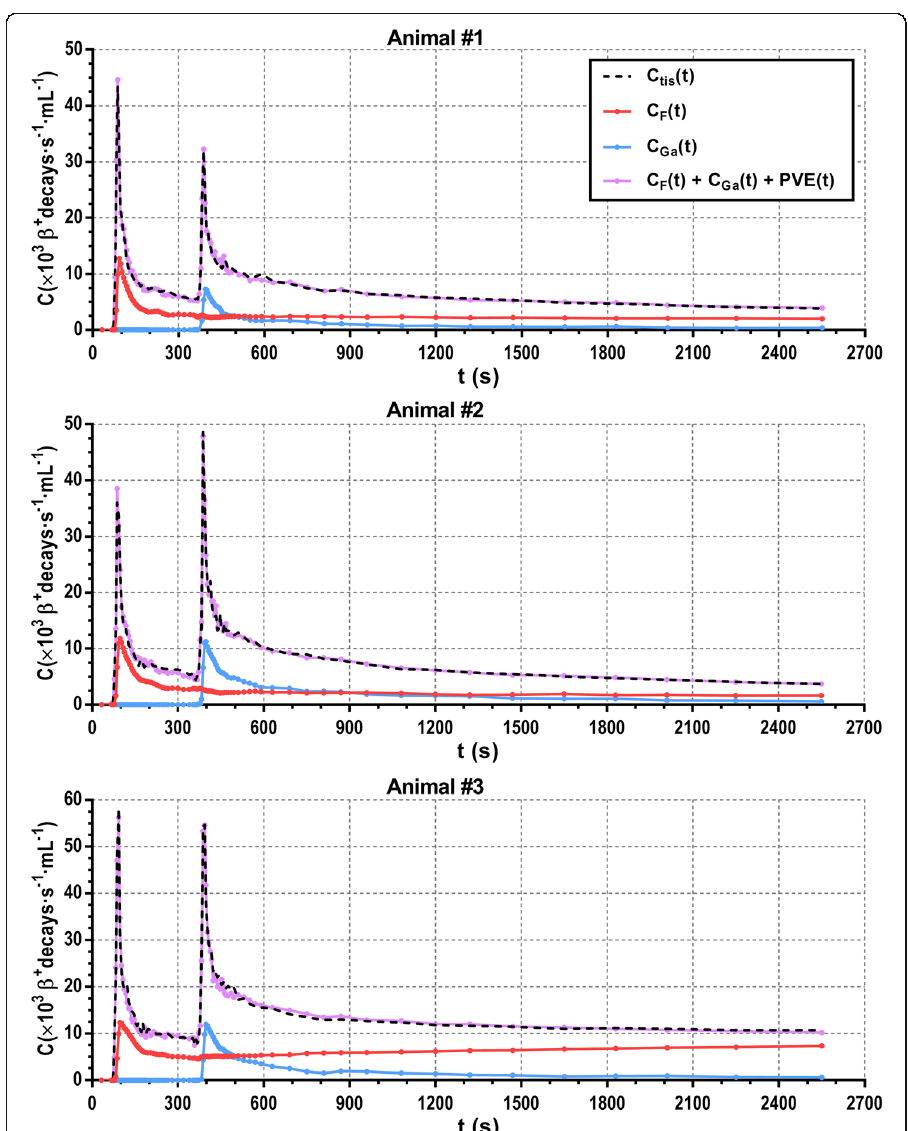
Fig. 7 Myocardial tissue TACs obtained from dynamic PET images for each animal included in this study (black dashed lines). Data was fitted to the multi-tracer compartment model shown in (5) (purple line) and separated into tissue TACs for 18 FDG (red) and 68 Ga-DOTA